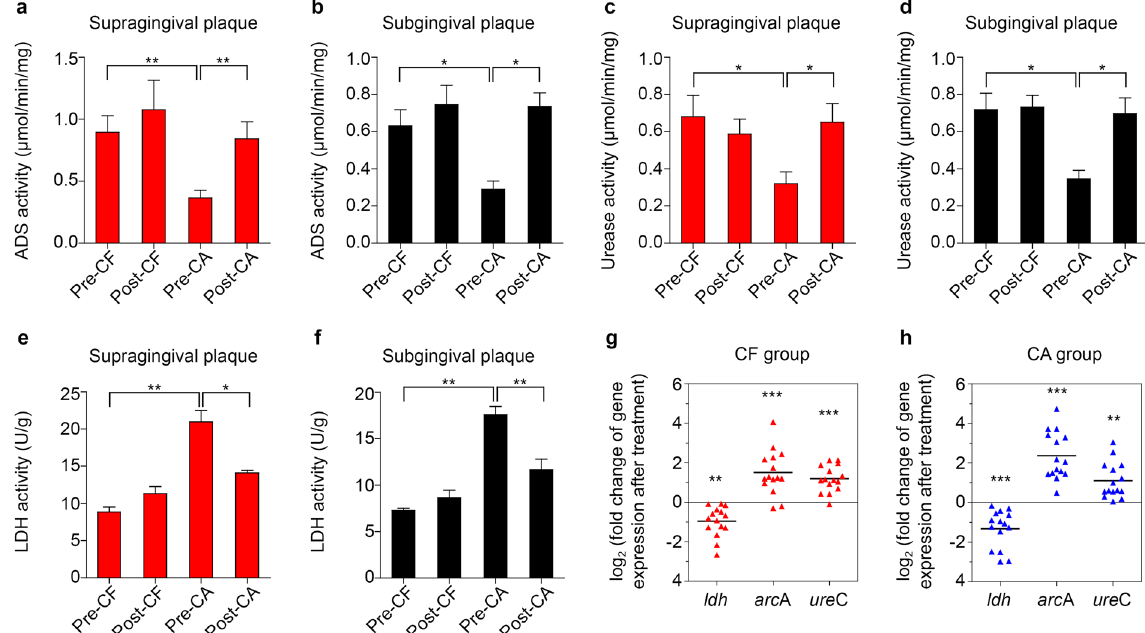
Figure 3. Treatment with arginine-containing dentifrice alters the enzymatic activity and expression of genes involved in microbial acid-base metabolism. Arginine deiminase system (ADS) ( a , b ), urease ( c , d ) and lactate dehydrogenase (LDH) ( e , f ) activities in supra- ( a , c , e ) and subgingival plaque ( b , d , f ). Data are presented as mean ± standard deviation (s.d.). (n = 15; one-way ANOVA test followed by Tukey’s test; * p < 0.05, ** p < 0.01). The relative fold changes of ldh , arcA and ureC expression levels in supragingival plaques after treatment of every subject in caries free (CF) group ( g ) and caries-active (CA) group ( h ) are plotted. Data are presented as the results after log 2 transformation, with the black horizontal lines representing the mean values (n = 15; paired sample t-test; ** p < 0.01, *** p < 0.001). Pre-CF and Post-CF = caries-free group before and after arginine- containing toothpaste treatment respectively; Pre-CA and Post-CA = caries-active group before and after arginine-containing toothpaste treatment